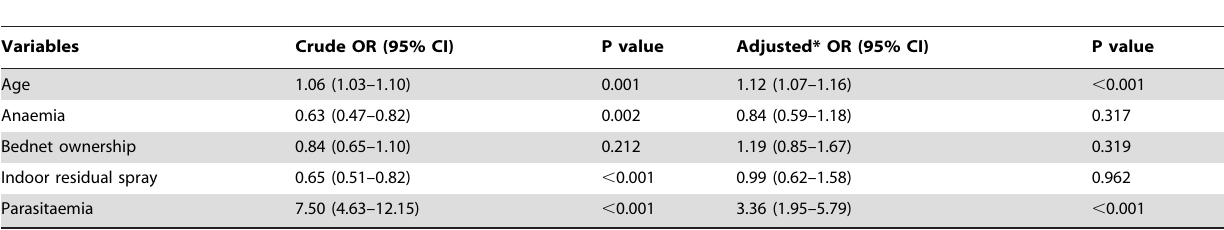
Table 2. Crude and adjusted estimates for the odds of being positive for antimalarial antibodies.